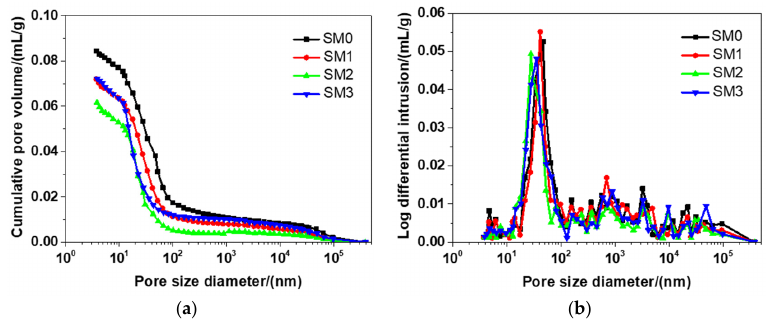
Figure 10. The pore size distribution of different kinds of siliceous sacrificial mortar at curing time of 28 days: ( a ) cumulative pore distribution curve; ( b ) differential pore distribution curve.